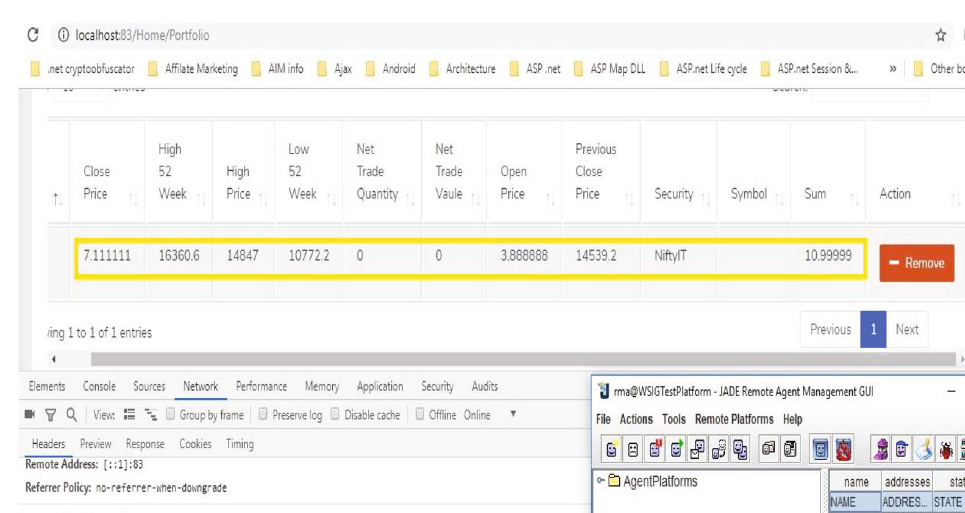
Figure 15: .NET precision value by